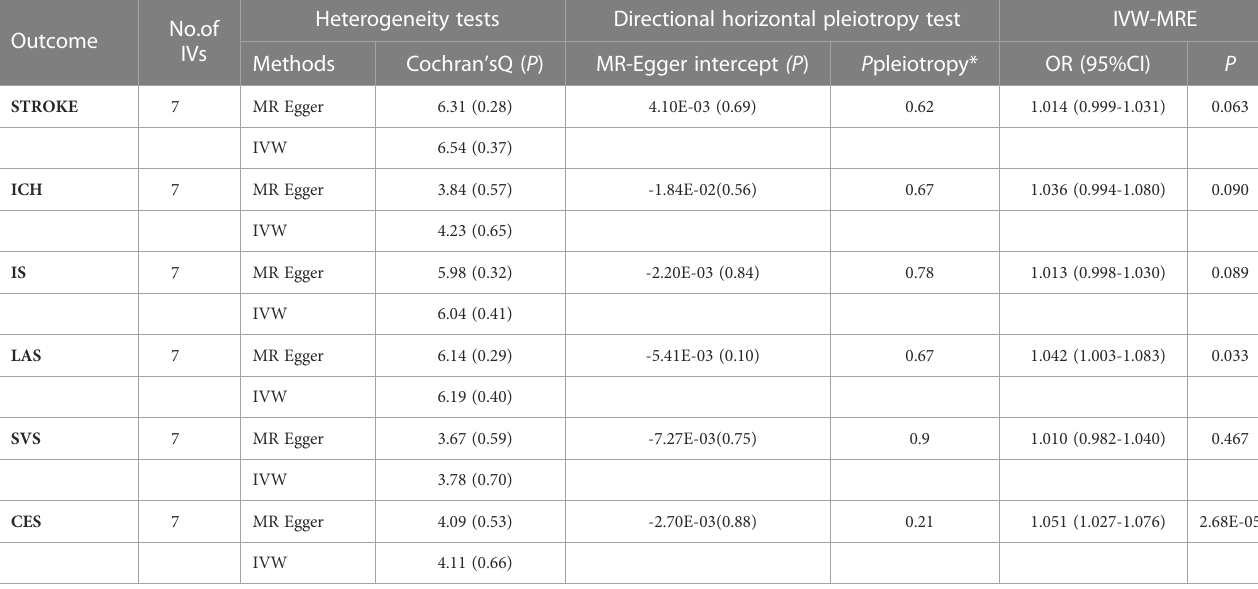
TABLE 3 MR Sensitivity Analyses of Genetically Predicted AS on stroke.